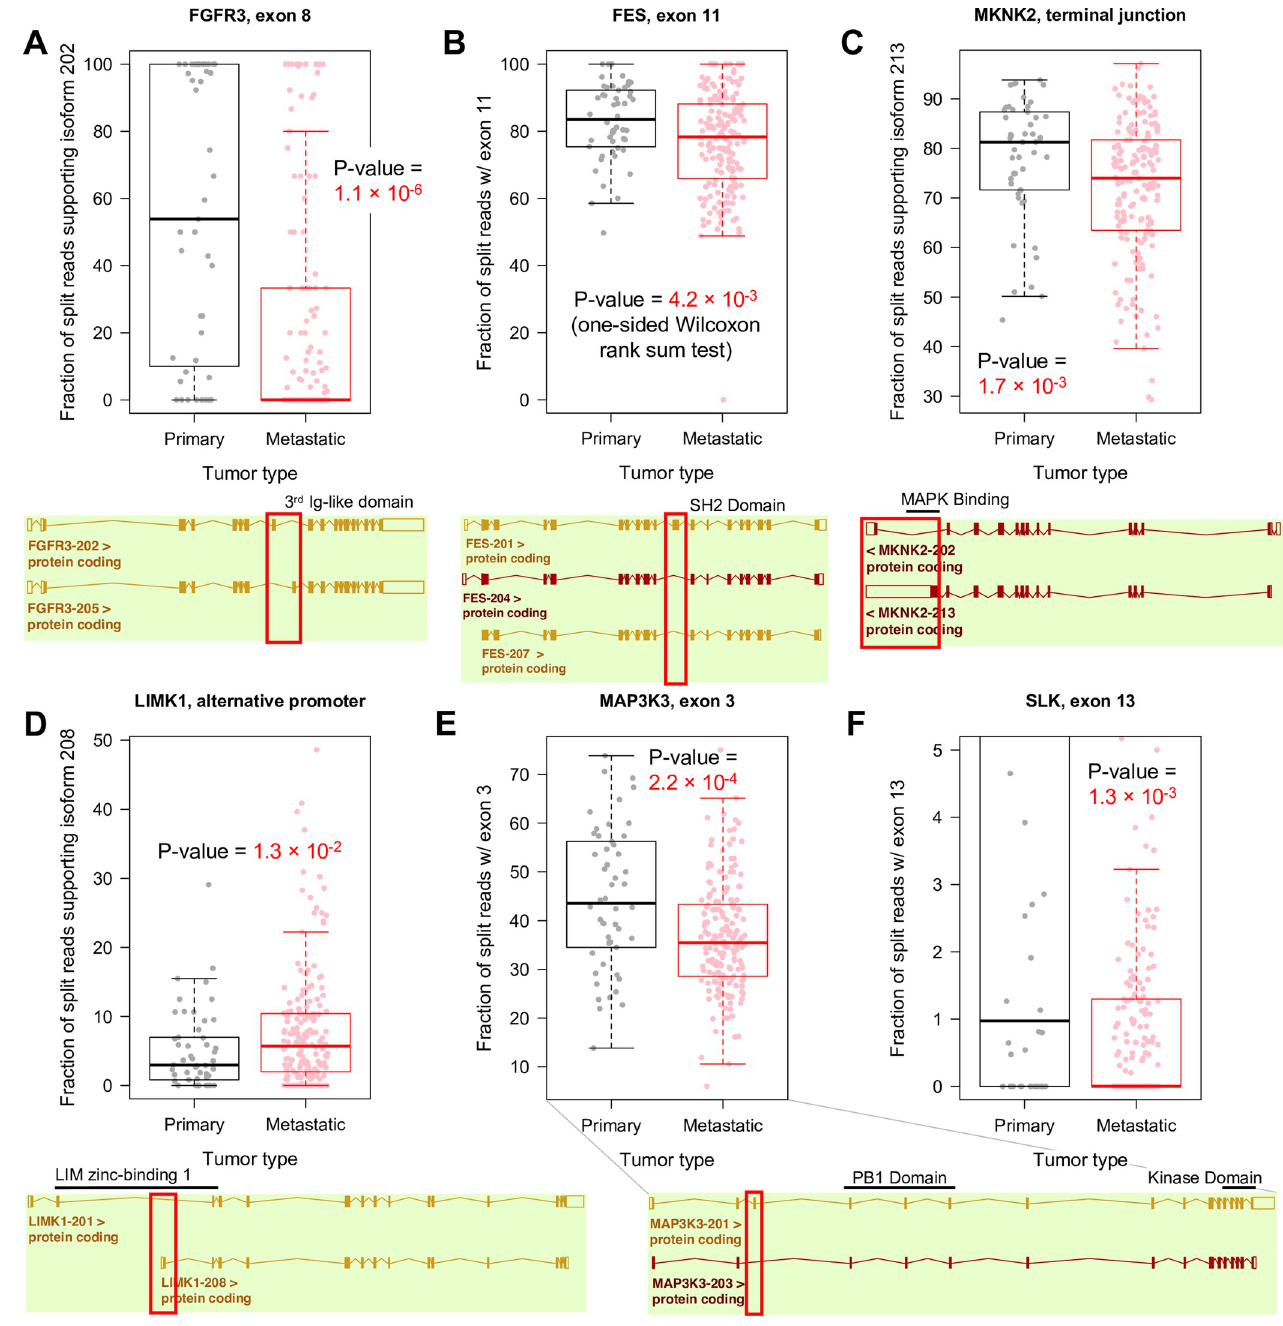
Fig 6. Alternative splicing between primary and metastatic samples. (A-E) Shown for each gene are box plots for fraction of split reads aligned to exon junctions in primary tumor and metastatic samples. Below, maps of each isoform identify the differential exon. (F) Zoomed-in plot for SLK. Half (89 / 178) of metastatic samples have no reads supporting exon 13. See Fig 7 for more